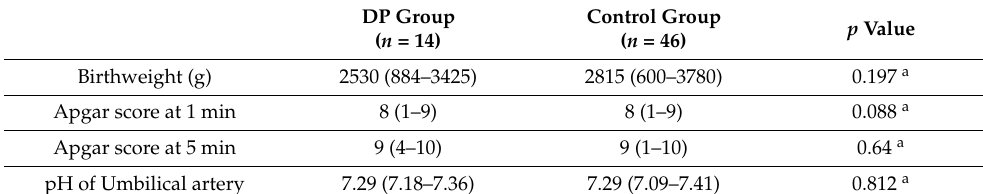
Table 2. Comparisons of neonatal outcomes between the study groups.